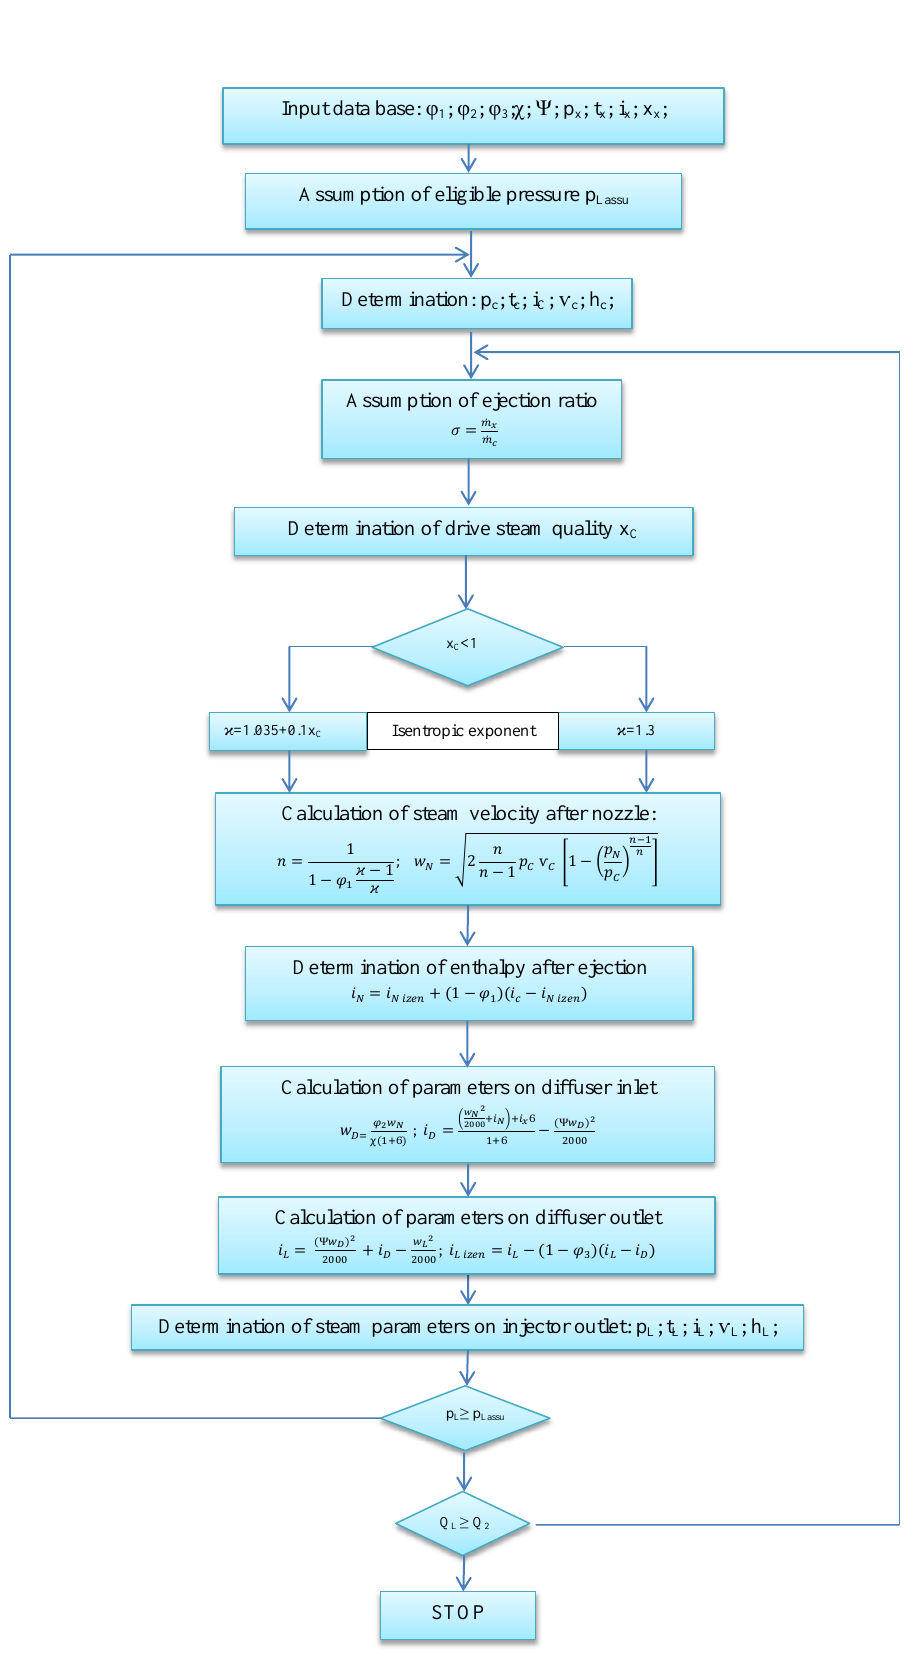
Figure 3. Algorithm of the regenerative injector calculation. Reproduced with permission from the MAPE Conference Organizing Team, published by New Trends in Production Engineering 2018.